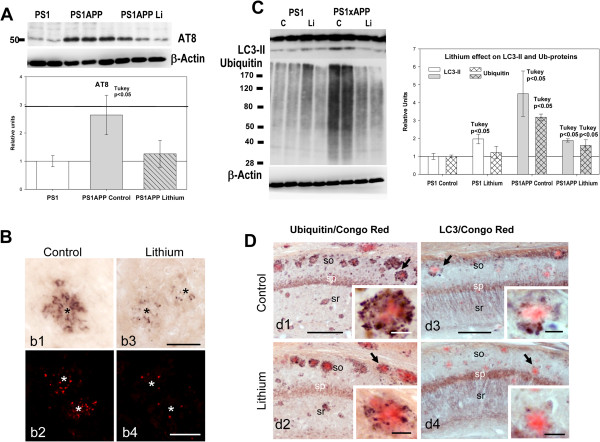
Lithium treatment reduced the dystrophic pathology associated to Abeta plaques. A) Representative western blot (n = 7 mice per group) and quantitative analysis of phosphorylated tau, determined using AT8 clone, of total proteins from PS1 control, PS1xAPP control and PS1xAPP lithium-treated mice. For quantification, the AT8 levels were referred to PS1 control group. The AT8 levels were significantly increased in PS1xAPP control mice (ANOVA F(2,18) = 22.66, p = 0.0001; Tukey p < 0.05) whereas PS1 control and PS1xAPP lithium displayed no differences. B) Representative AT8 positive dystrophies surrounding Abeta plaques from control (b1 and b2) or lithium treated (b3 and b4) PS1xAPP mice. C) Representative western blots and quantitative analysis of steady-state levels of LC3-II and ubiquitinated proteins in PS1 and PS1xAPP control and treated mice (n = 4 per genotype and treatment). A clear and significant accumulation of both LC3-II (ANOVA F(3,12) = 32.52, p = 0.001) and ubiquitinated proteins (ANOVA (F(3,12) = 63.67, p = 0.00001) was observed in PS1xAPP control mice. Lithium treatment reversed this pathology. The post-hoc analysis, using Tukey test, was indicated in the figure. D) Ubiquitin (d1 and d2) and LC3 (d3 and d4) immunolabeled hippocampal sections (counterstained with Congo red for Abeta plaques) of control and lithium treated PS1xAPP mice corroborated the accumulation of both markers, associated with dystrophic neurites surrounding amyloid plaques (d1 and d3) and the patent lithium reduction (d2 and d4) in the presence of ubiquitin and LC3 positive dystrophies. Inserts in d1-d4 showed higher magnification details of the dystrophies surrounding Abeta plaques. so, stratum oriens; sp, stratum pyramidale; sr, stratum radiatum. Scale bars: b1, b3 50 μm; b2, b4 100 μm; d1 to d4 200μm; inserts 25 μm.